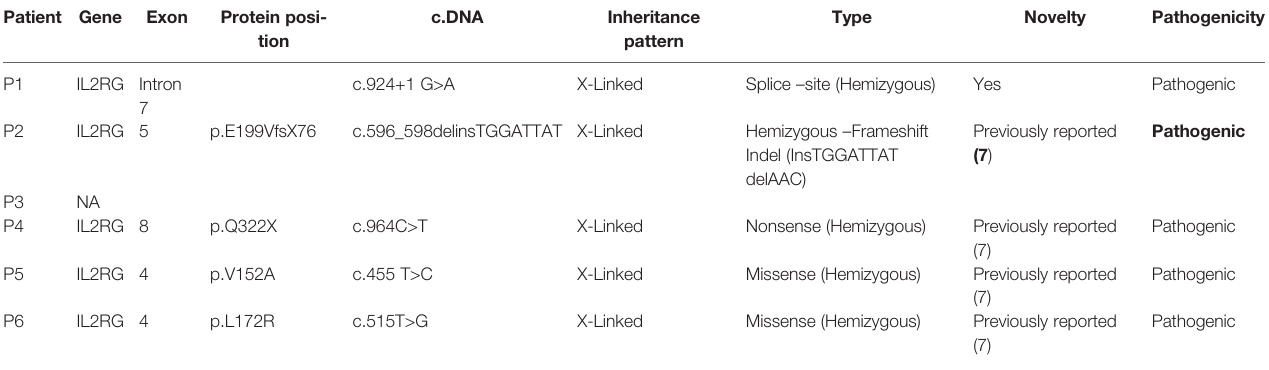
TABLE 4 | Detailed genetic reports of SCID patients with HLH in the present